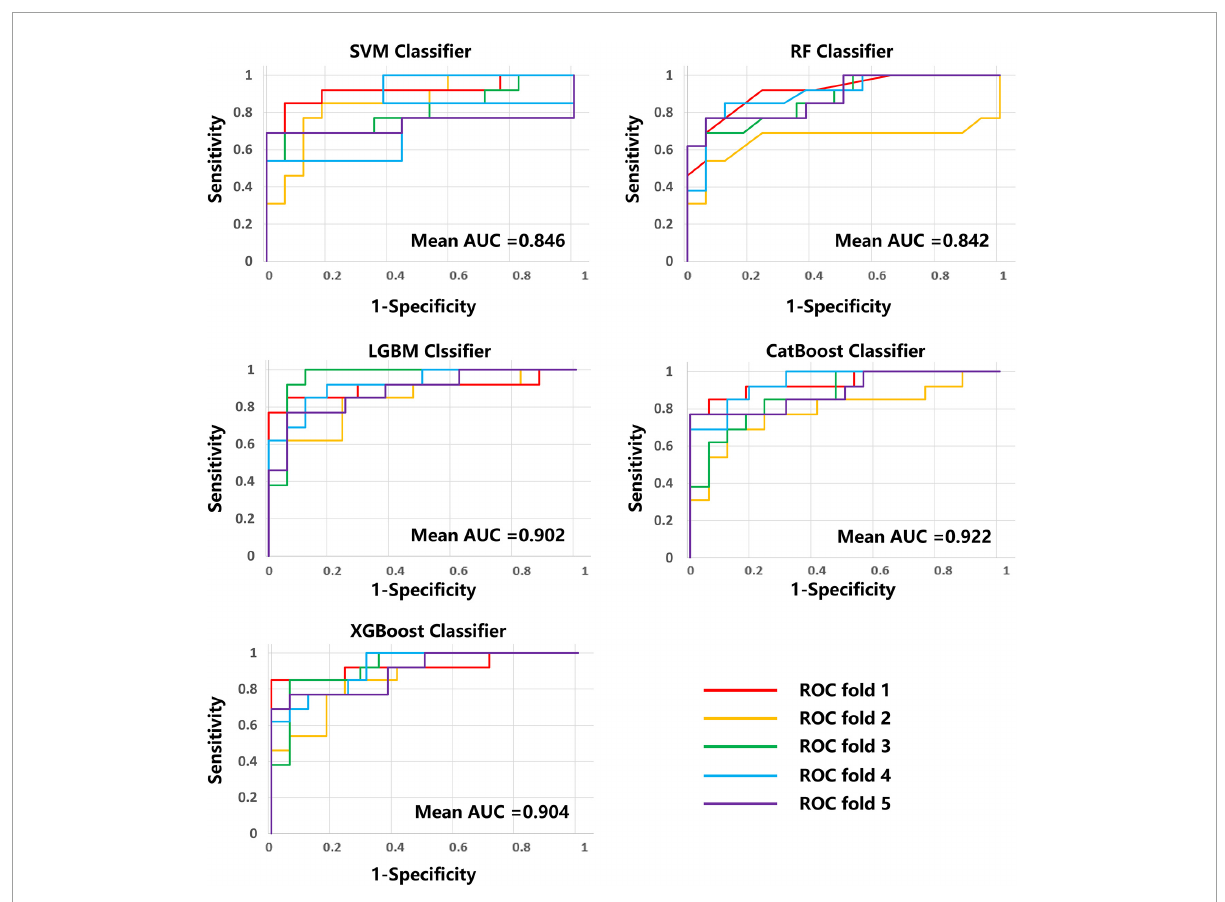
FIGURE4 ROC curves and AUC values of the five models on five-fold cross-validation. ROC, received operating characteristic; AUC, area under the